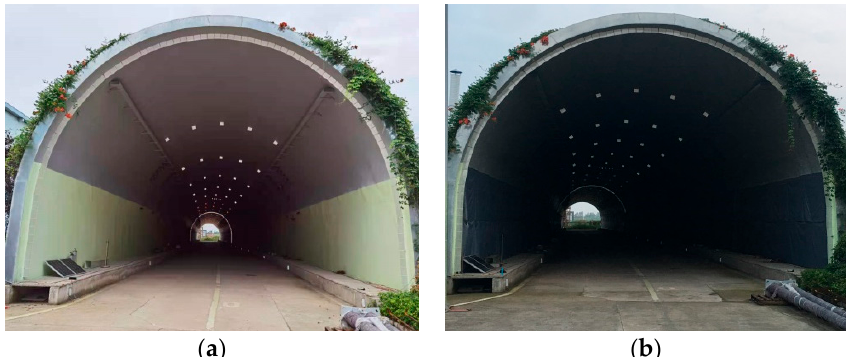
Figure 2. Tunnel appearance and decoration. ( a ) Sidewalls with energy ‐ storage and luminescent coating, ( b ) sidewalls with gray cloth.